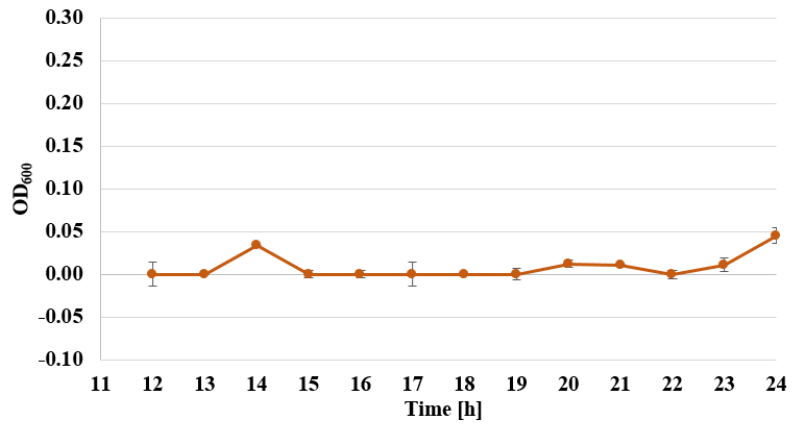
Figure 5. Changes of absorbance in Alamar Blue test for the strain S. epidermidis ATCC 12228, exposed to the activity of nanosilver particles with sizes of 10 nm and a concentration of 7 µg/mL between the 12th and 24th hour ( λ = 600 nm).